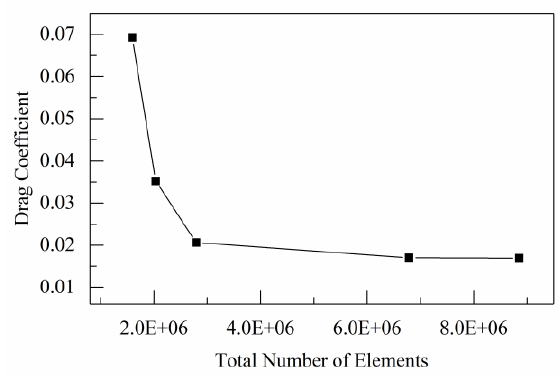
Figure 7. E ff ect of grid number on drag Figure 7. Effect of grid number on drag reduction.